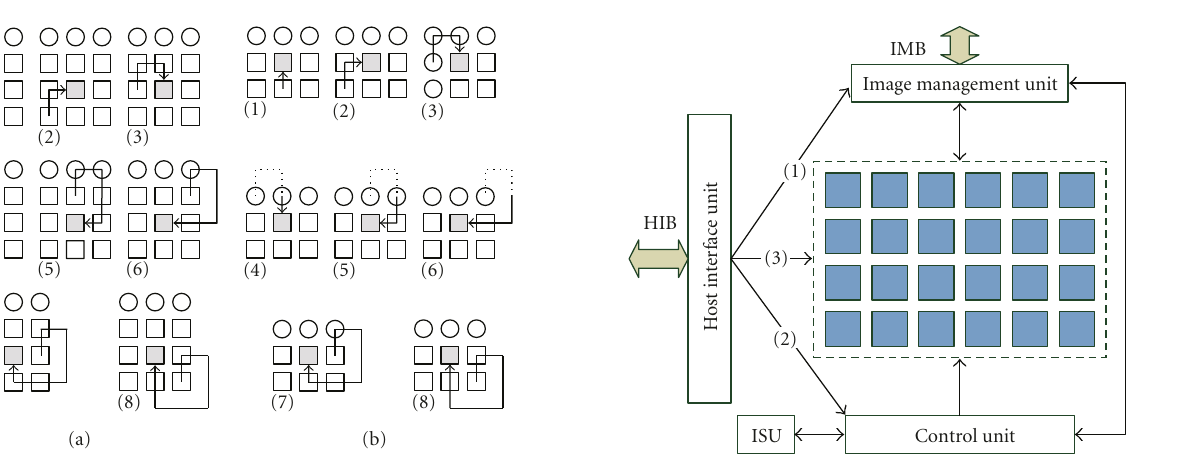
Figure 19: External view of the CNN